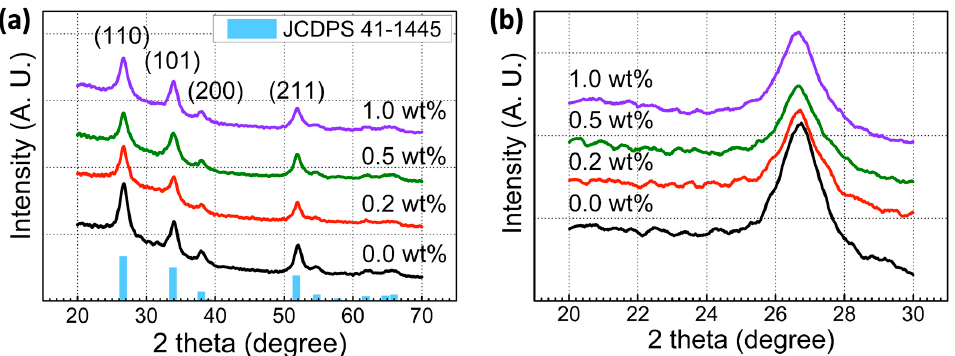
Figure 1. ( a ) GIXRD patterns and ( b ) the GIXRD patterns near the (110) lattice plane with di ff erent Ywt%. Table 1. Crystalline size, microstain, and dislocation density of Y-doped SnO 2 semiconductor films with di ff erent